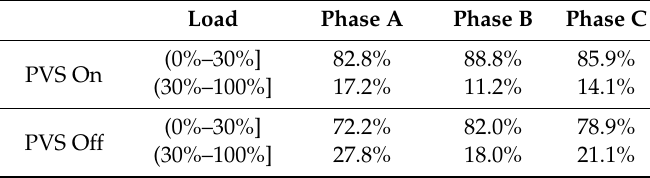
Table 3. Probability of occurrence of scenarios with load ranges of 0%–30% and 30%–100%.